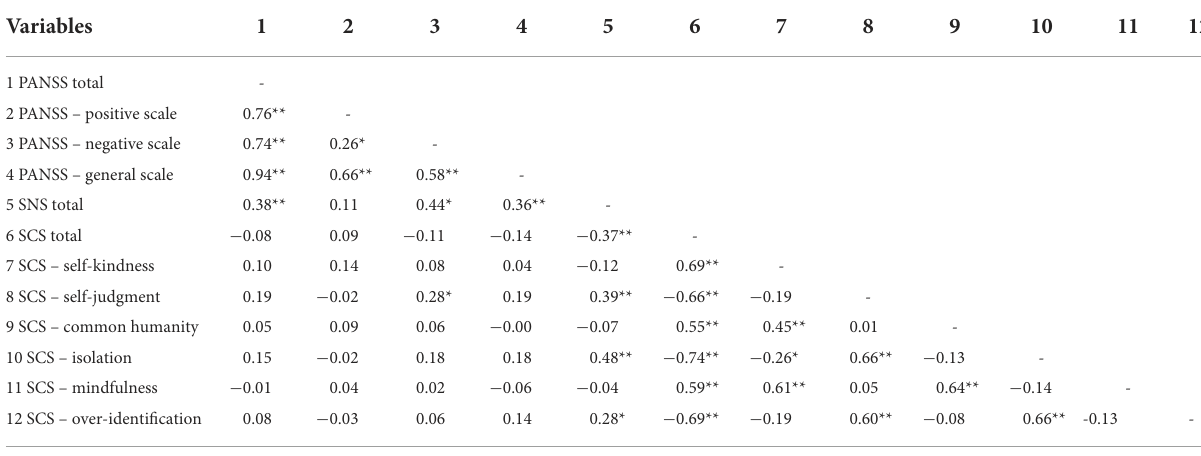
TABLE 2 Correlations for symptom severity and SCS subscales.